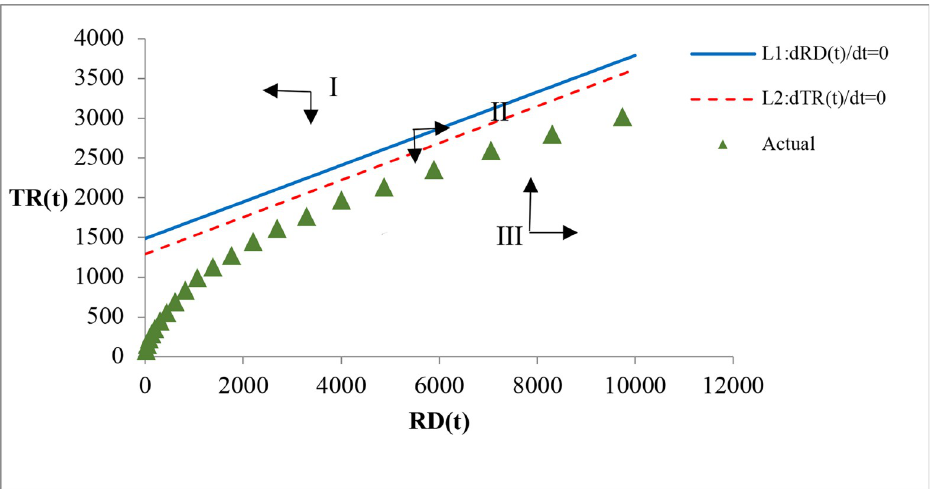
Fig 3. Partial magnified view of the evolutionary trend of RD and